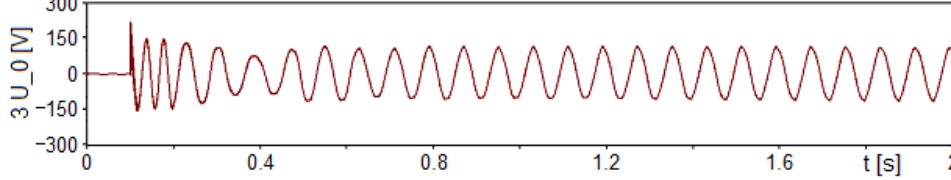
Figure 9. The voltage waveform in the open delta circuit as a result of changing the magnetization characteristics of the voltage transformers from waveform 2 to 1.